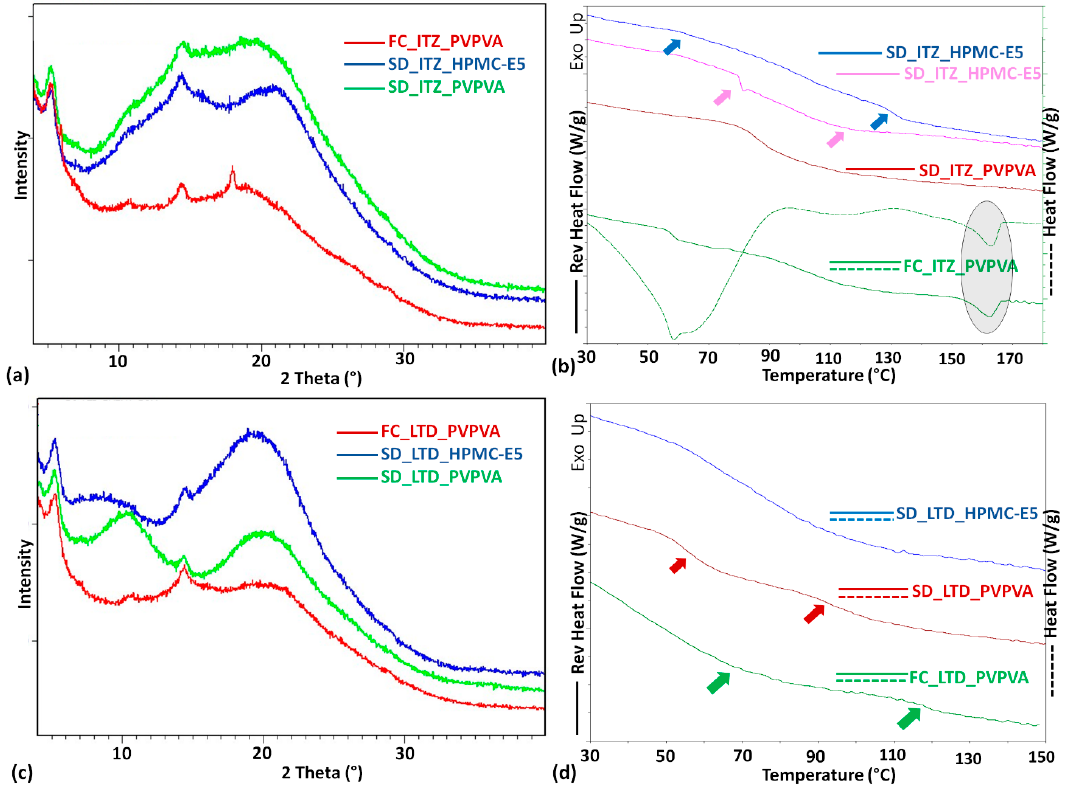
Figure 4. Overlay of PXRD patterns and mDSC thermograms of different ASDs samples of ( a )–( b ). Itraconazole and ( c )–( d ) Loratadine. Arrows in the mDSC thermograms mark more than T g events (phase separation). The endothermic peak of melting event in the case of film-casted ITZ_PVPVA sample is marked by a shaded ellipsoid.